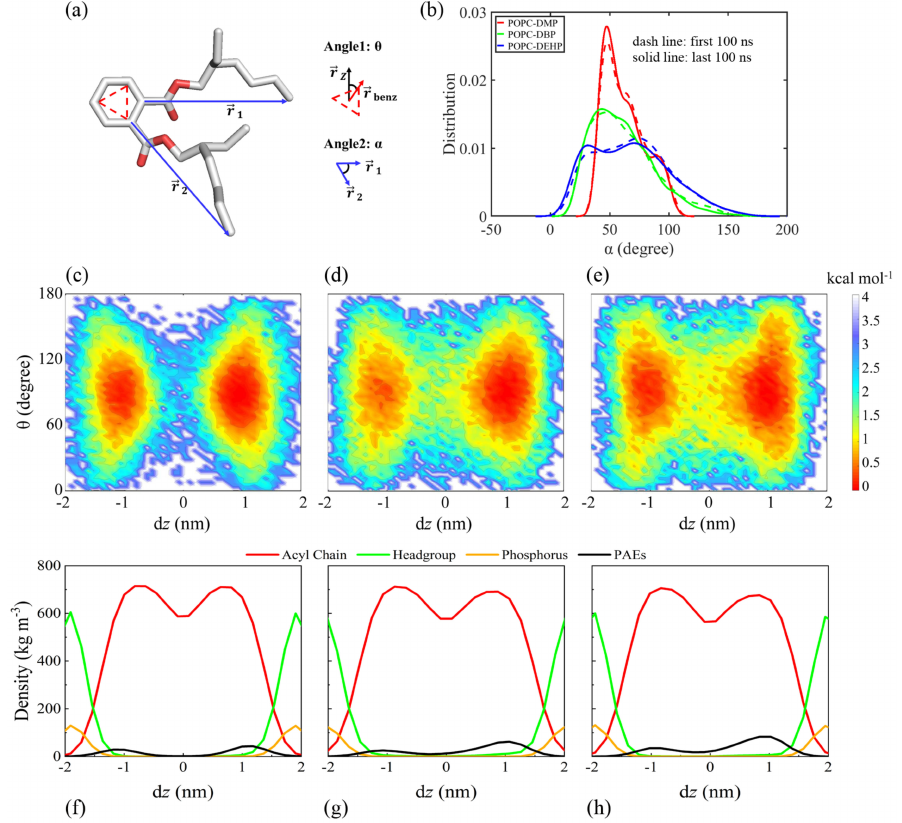
Figure 3. Orientation of DMP, DBP, and DEHP in all-atom cMD simulations. ( a ) Definitions of angle θ and α . ( b ) Distribution profiles of angle α for all systems. The dashed line and solid line represent two phases of PAEs: not yet or completely inserted into the membrane, respectively. ( c – h ) Free energy surface ( c – e ) based on d z (the COM distance of PAEs’ benzene ring and POPC membrane along the z direction) and angle θ , as well as the density distribution profiles ( f – h ) of several essential components along the d z vector for system POPC-DMP ( c , f ), POPC-DBP ( d , g ) and POPC-DEHP ( e , h